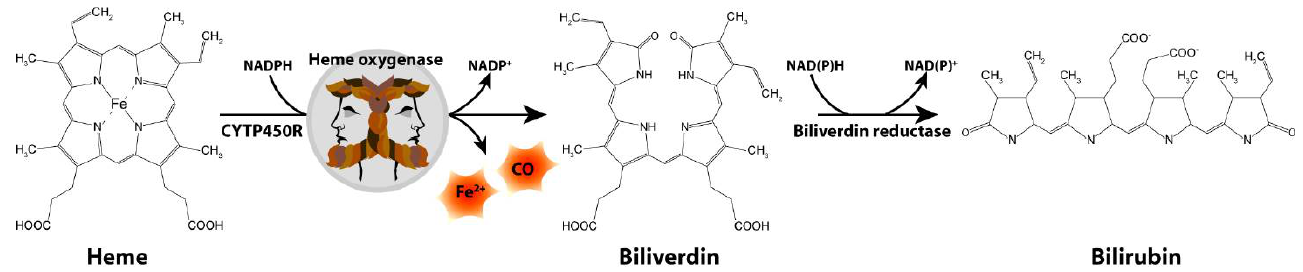
Figure 1. Heme degradation pathway. CO, carbon monoxide; CYTP450R, cytochrome P450 reductase; Fe 2+ , ferrous iron.